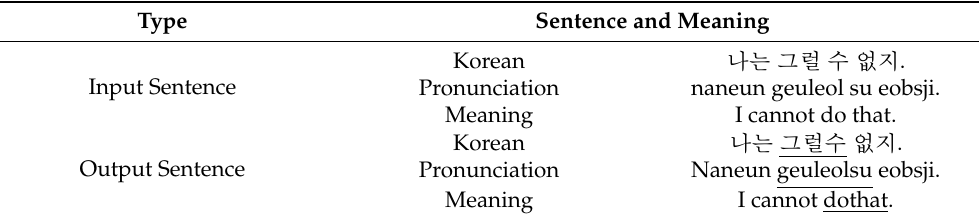
Table 4. Example of Output Sentence of ChatSpace according to Input